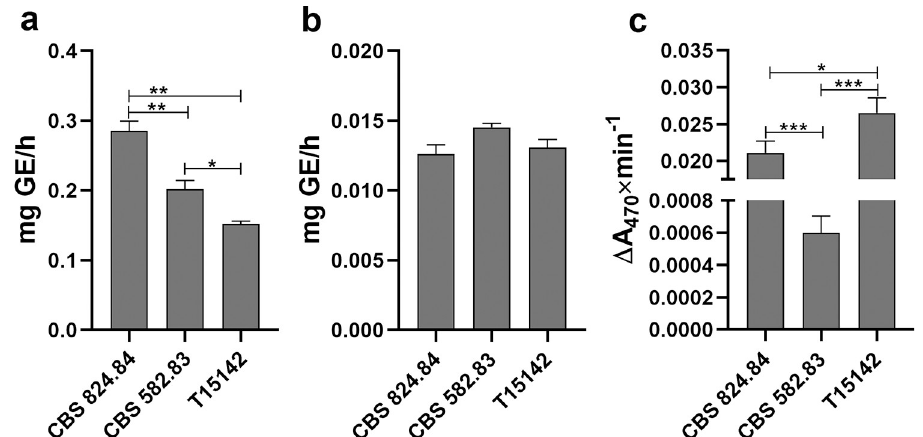
Fig 6. Exoenzyme production of K . longispora isolates in liquid cultures. Cellulase ( a ) pectinase ( b ) and laccase ( c ) activities of strains CBS 824.84, CBS 582.83, and T15142 grown in liquid minimal media for 7 days at 25˚C with 180 rpm shaking. GE: Glucose equivalent of released reducing sugars. Asterisks mark significances of differences ( � p < 0.05, �� p < 0.005, ��� p < 0.0005).